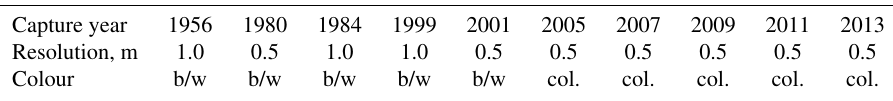
Table 1. Orthophoto dataset properties.